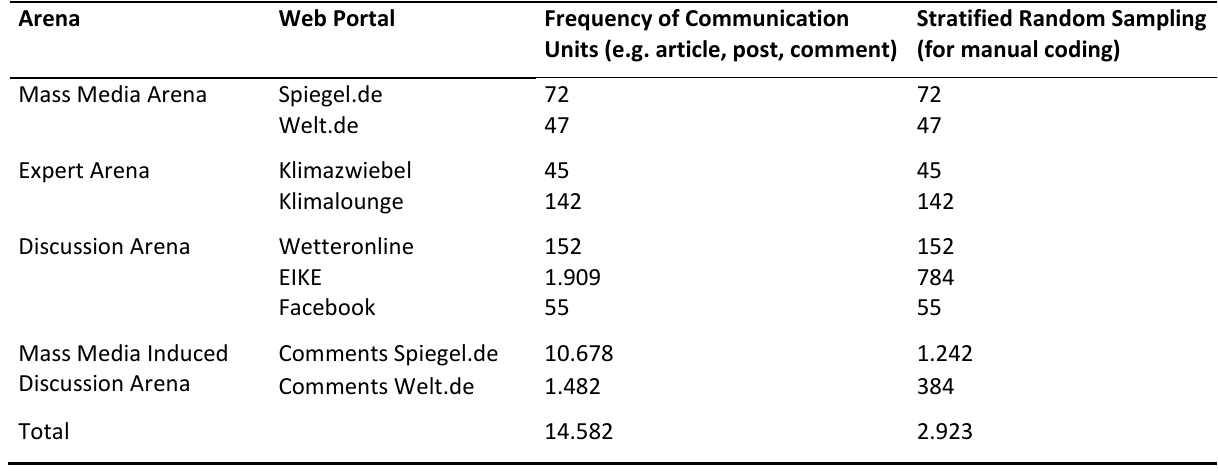
Table 4. Web portal frequencies . Web Portal Frequency of Communication Units (e.g. article, post, comment)